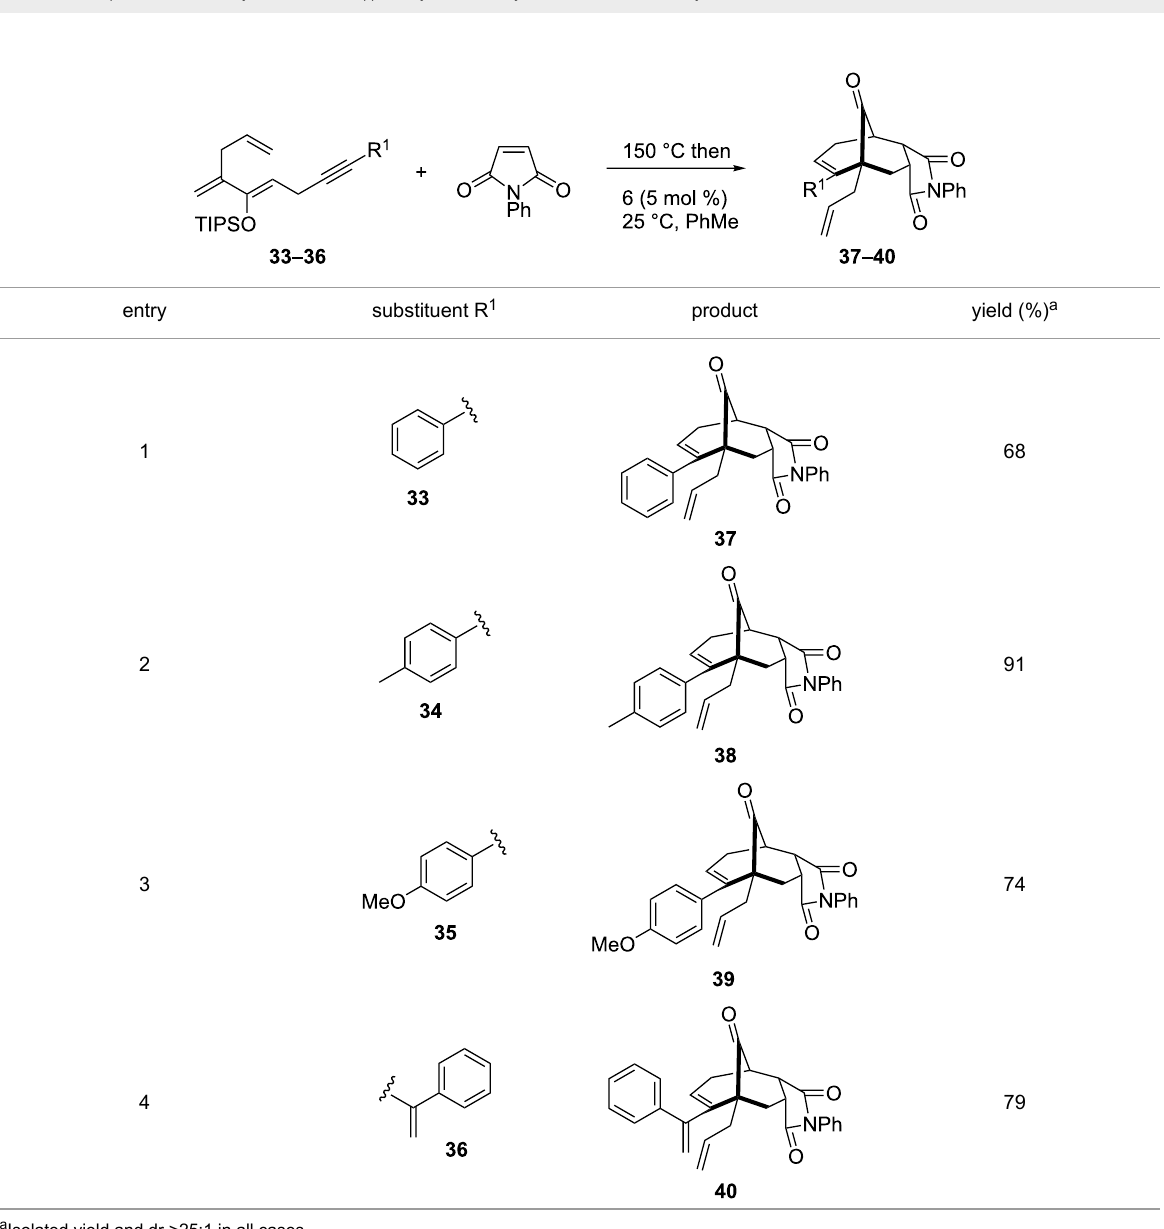
Table 2: One-pot Diels–Alder cycloaddition/Au(I)-catalyzed carbocyclization of internal